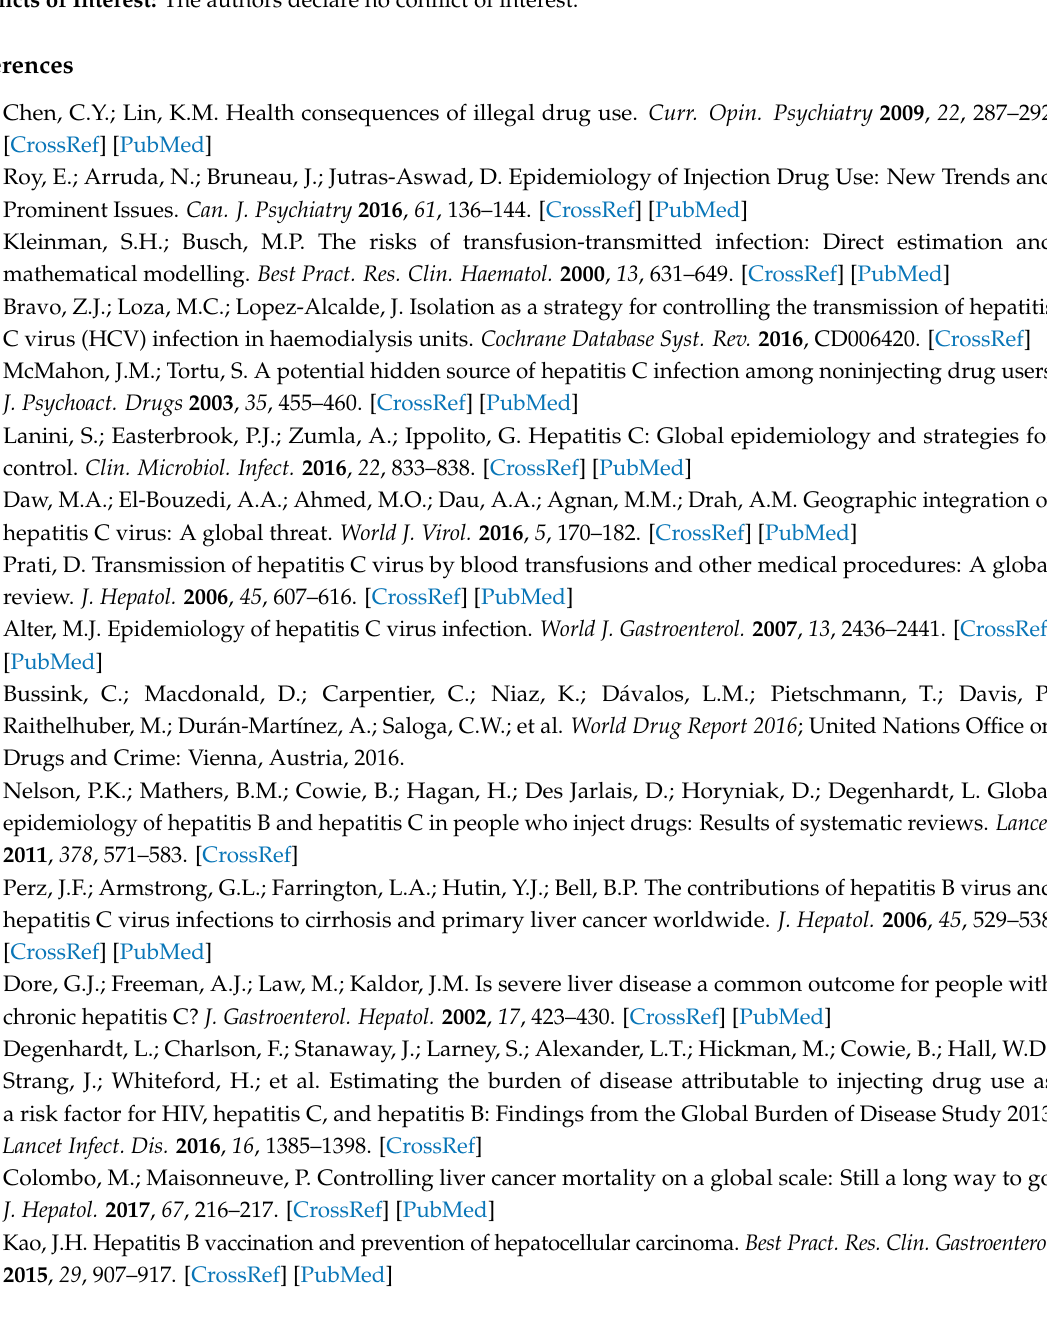
s1, Table S1: Age-period- cohort model analysis results for global mortality of IDU-attributable cirrhosis, Table S2: Age-period-cohort model analysis results for global mortality of IDU-attributable liver